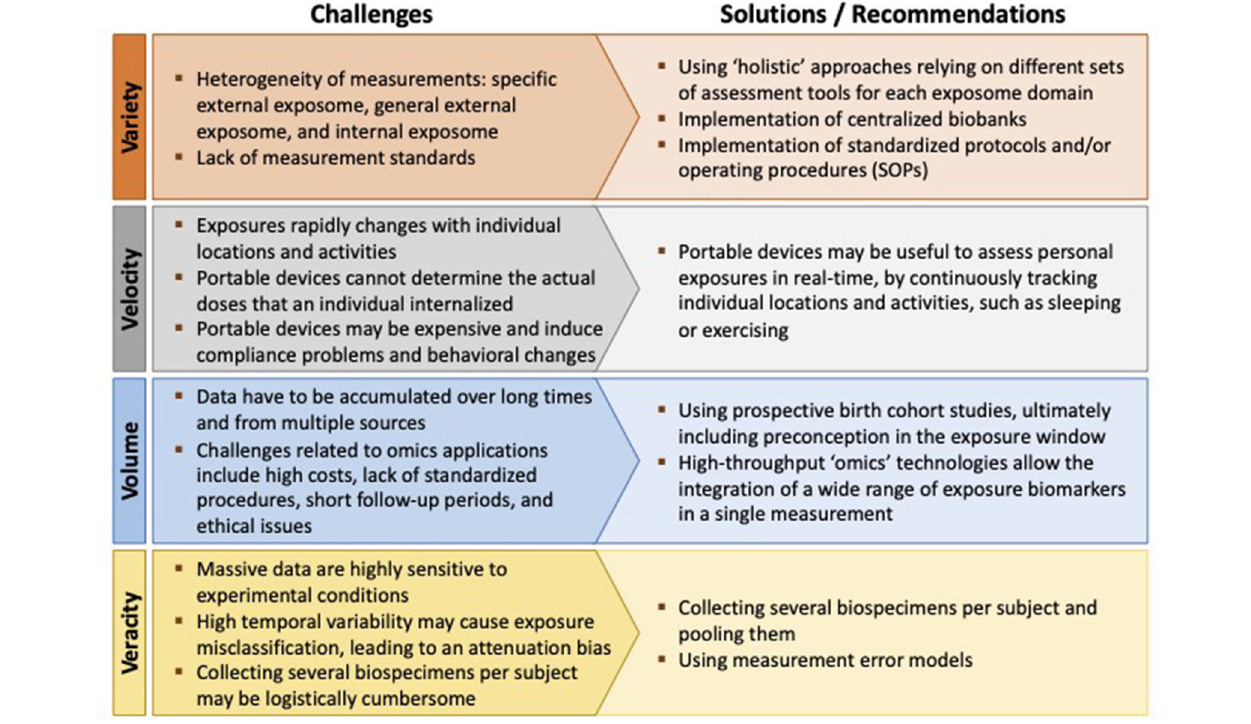
be included in a final multi-exposure model (29). The